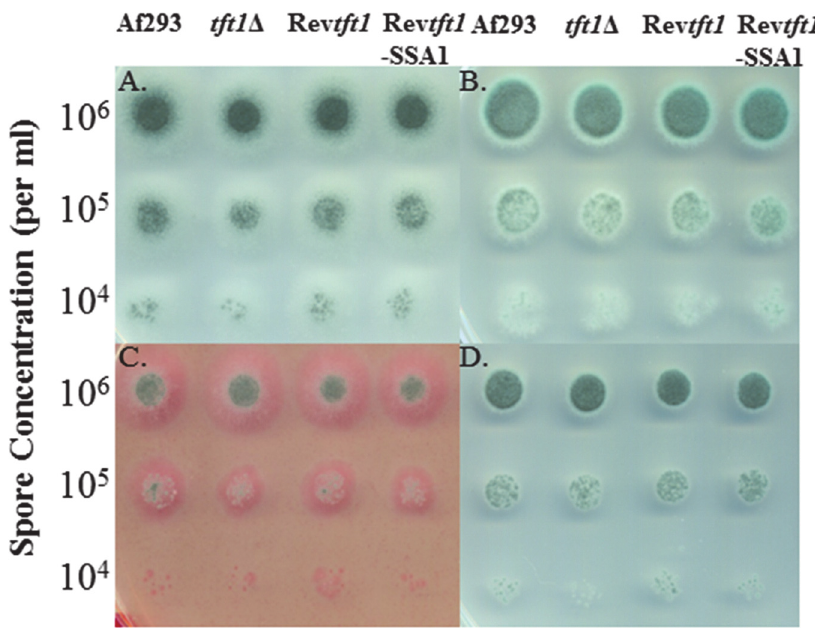
Fig 3. In vitro growth of the Tft1 transformant strains. Strains grown on, A. Aspergillus Minimal Media (AMM); B. AMM+Farnesol; C. AMM+Congo Red; or D AMM-Calcofluor white. No apparent differences in phenotype were observed between the strains and